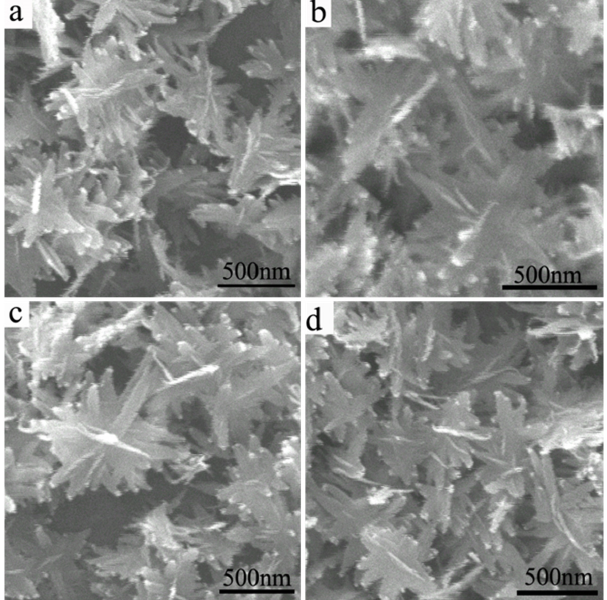
Figure 3. SEM images of CuO nanosheets with different reaction times: ( a ) 0.5 h, ( b ) 1 h, ( c ) 2 h, and ( d ) 3 h.